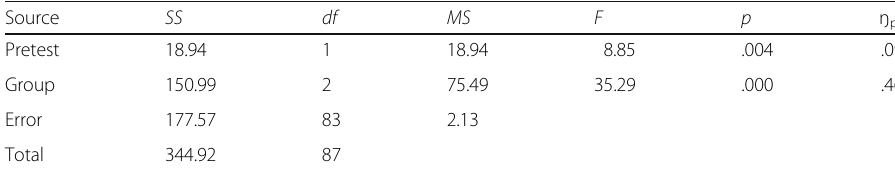
Table 12 Results of one-way ANCOVA for metalinguistic knowledge test Source SS df MS F p ŋ p 2 Pretest 18.94 Group 150.99 Error